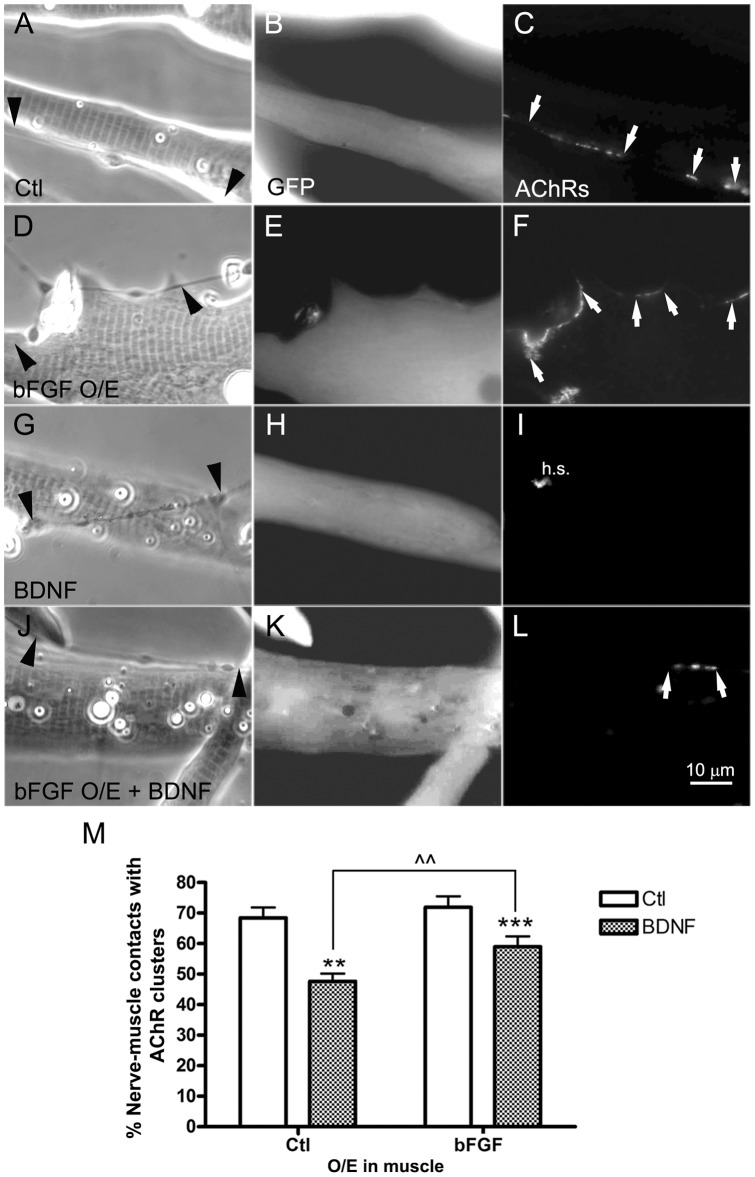
Reciprocal regulation of NMJ formation by bFGF/NT-signaling.Normal spinal neurons were cocultured with muscle cells expressing GFP (A–C and G–I) or GFP plus bFGF (bFGF O/E; D–F and J–L) and maintained in control medium (A–F) or medium with added BDNF (G–L). Neurons induced AChR clusters equally well in GFP- and bFGF-muscle cells (C, F), and BDNF-treatment inhibited synaptic AChR clustering in both cases (I, L). The inhibitory effect of BDNF, however, was weaker when muscle cells expressed excess bFGF, and in these cases nerve-muscle contacts with AChR were more readily found (L). Muscle cells in which nerves induced new AChR clusters lacked spontaneously occurring AChR aggregates (also called hot-spots); when AChR aggregation at innervation sites was compromised, AChR hot-spots were retained (h.s. in panel I). Synaptogenesis was quantified in terms of the percentages of nerve-muscle contacts with AChR clusters (M). Mean and SEM shown; t test: **p<0.01 and ***p<0.001, compared to cocultures with normal muscle cells; ??p<0.01, compared with BDNF-treated cocultures using bFGF-overexpressing muscle cells. Arrowheads point to nerve tracks, arrows to nerve-induced AChR clusters.